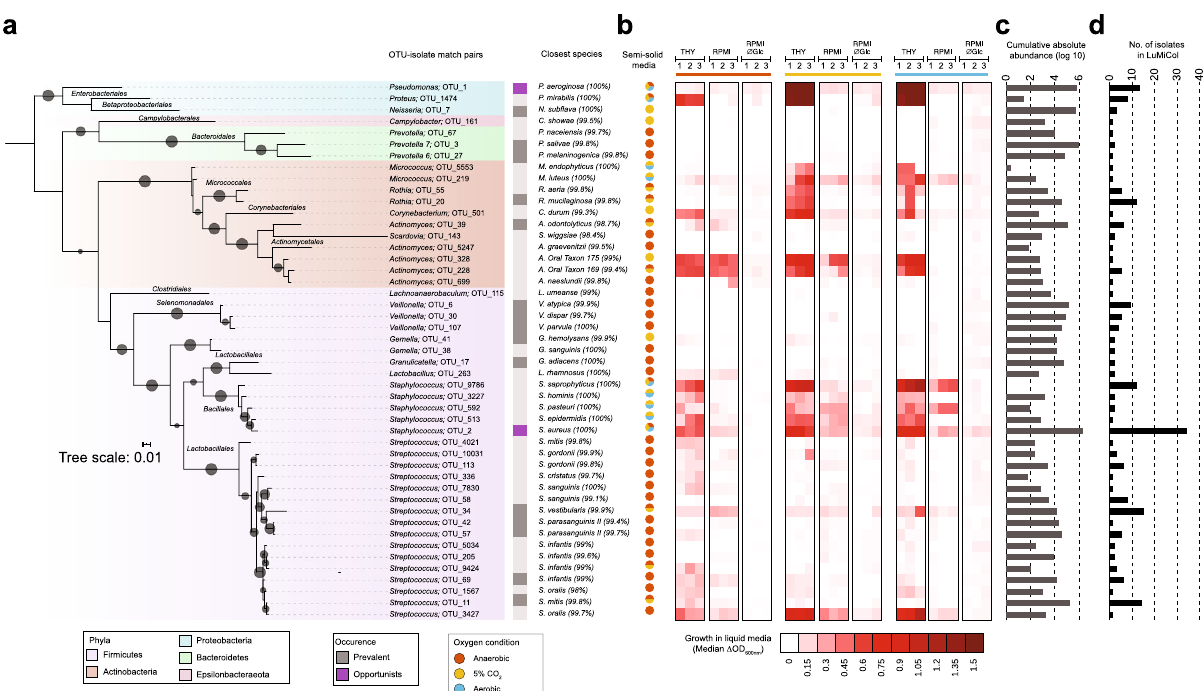
Fig. 2 A lung microbiota culture collection (LuMiCol) reveals extended diversity and phenotypic characteristics of the lower airway bacterial community. a Phylogenetic tree of the 47 OTU-isolate matching pairs inferred with FastTree. Branch bootstrap support values (size of dark gray circles) ≥ 80% are displayed. b Growth characteristics of each OTU-isolate matching pair in three different oxygen conditions (Anaerobic - light brown, 5% CO yellow, aerobic-light blue, n = 3). Column with pie charts shows growth on semi-solid agar. Heatmap shows median change in Optical Density (OD) at 600 nm growth in three different liquid media (THY, RPMI, RPMI without glucose) over 3 days. c Cumulative counts of each OTU-isolate matching pair across all BALF samples (gray). d Number of isolates in Lumicol (black) per OTU-isolate matching pair. Taxa are labeled as genus; OTU ID, with an indication of whether they are prevalent (gray rectangle) or opportunistic (magenta rectangle) in the lower airway community. The names of the closest hit in databases: eHOMD and SILVA are used as species